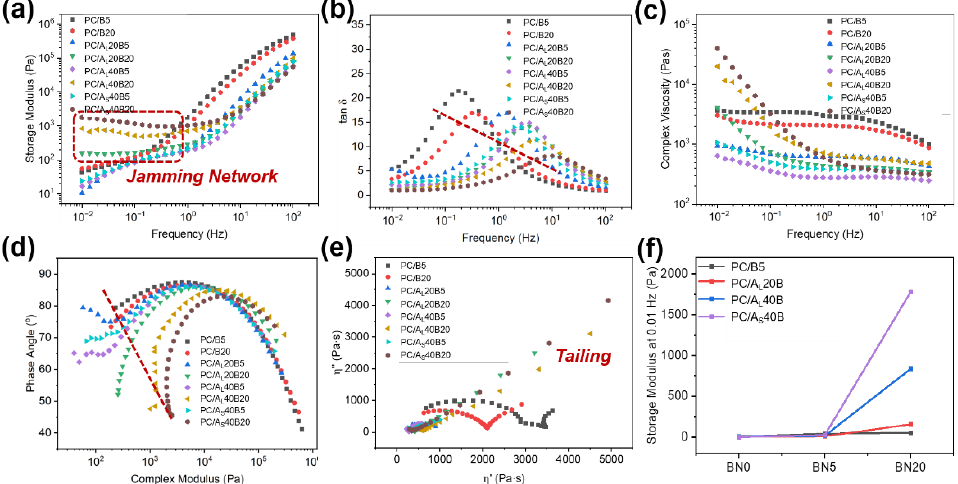
Figure 7. Rheological properties of PC/BN and PC/Al 2 O 3 /BN composites: ( a ) storage modulus vs. frequency, ( b ) tan δ vs. frequency, ( c ) complex viscosity vs. frequency, ( d ) phase angle vs. complex modulus, ( e ) 𝜂 ’’ vs. 𝜂 ’ , and ( f ) storage modulus at 0.01 Hz for different filler-containing composites.